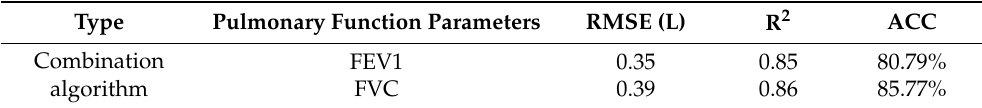
Table 6. Results of the combination